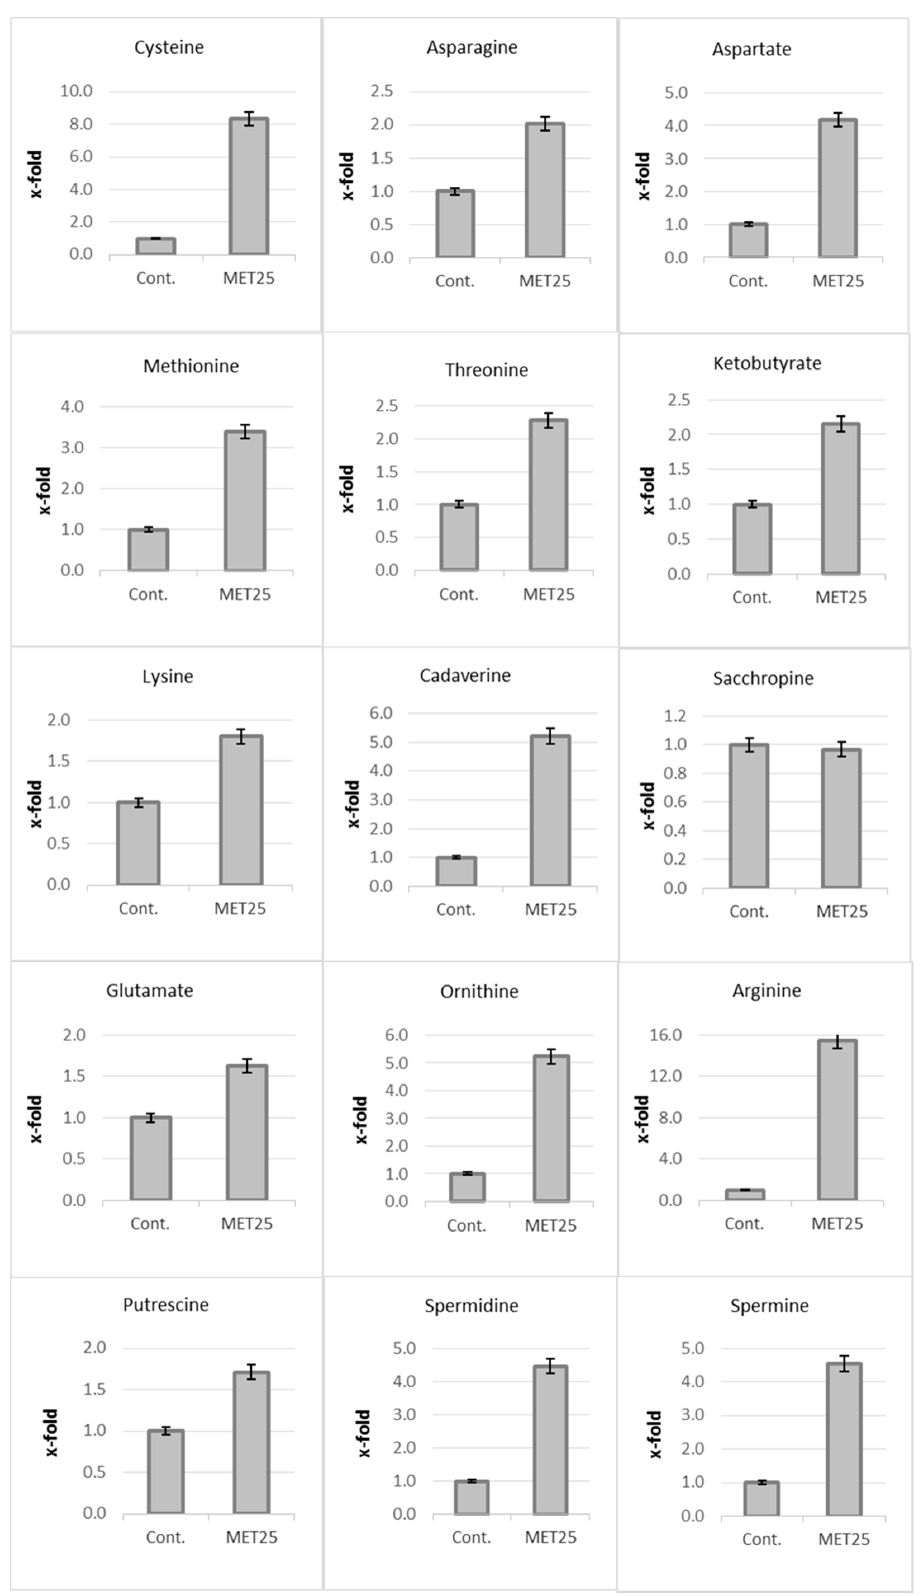
Figure 3. Content of metabolites resulting from detoxification and assimilation of cyanide ions. Met25 plants compared to control plants (Cont.); six independent measurements ± SD are presented.